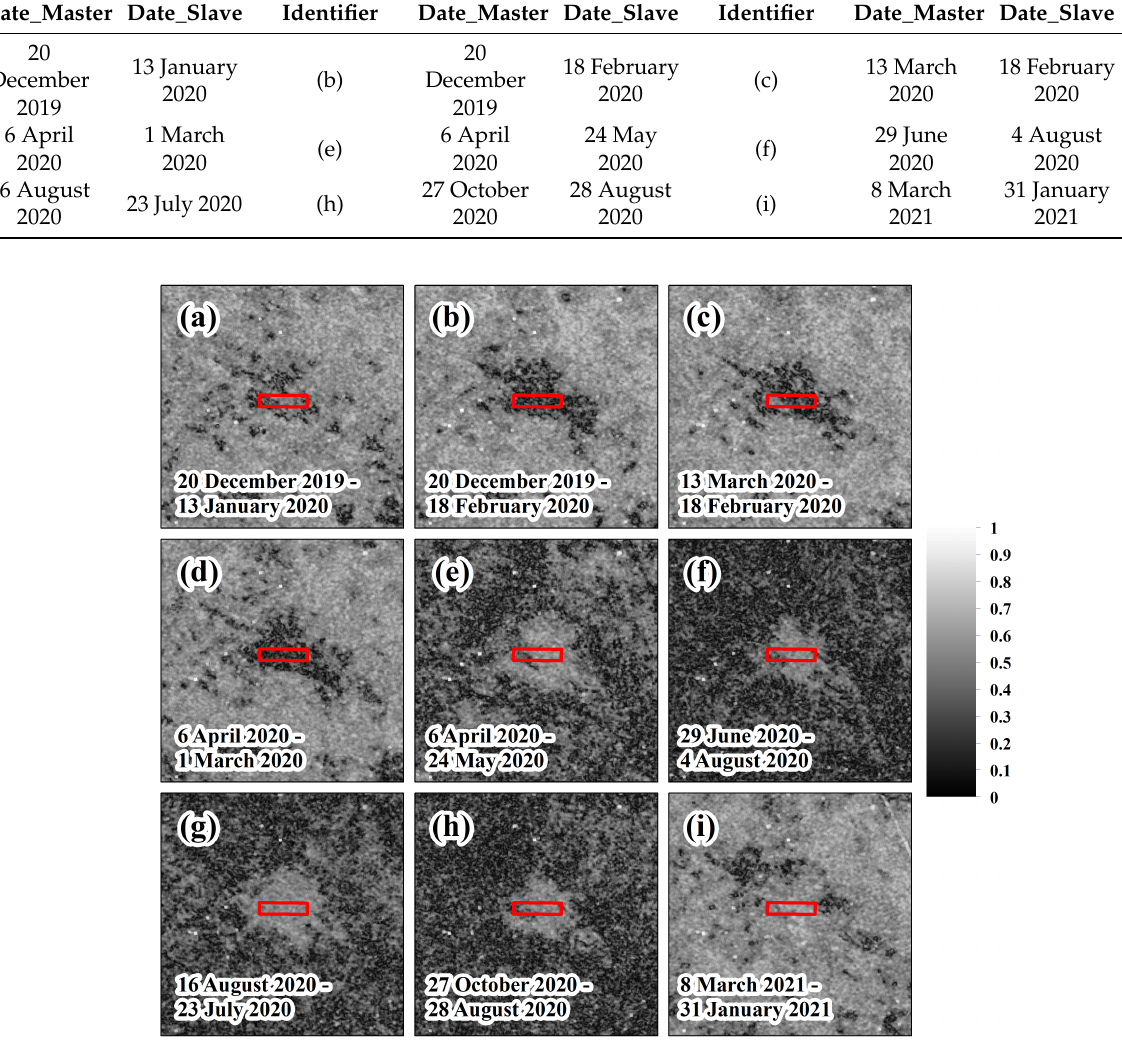
Figure 6. Coherence images. Subfigures ( a – i ) are the coherence images corresponding to the image pairs in Table 3. The layout of the 2401 working face is marked by the red